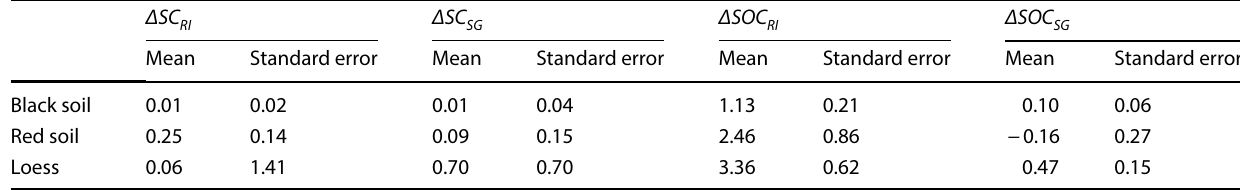
Table 2 Effects of rainfall intensity and slope gradient on sediment concentration (g L −1 m −2 ) and SOC loss rate (g m −2 h −1 ) for black soil, red soil and loess